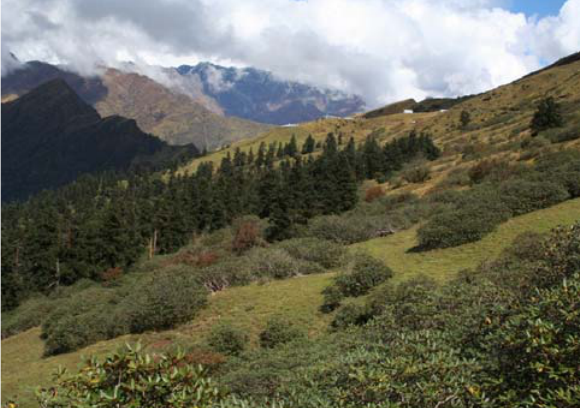
Image 3. Orange Awlet, Bibasis jaina (upper)